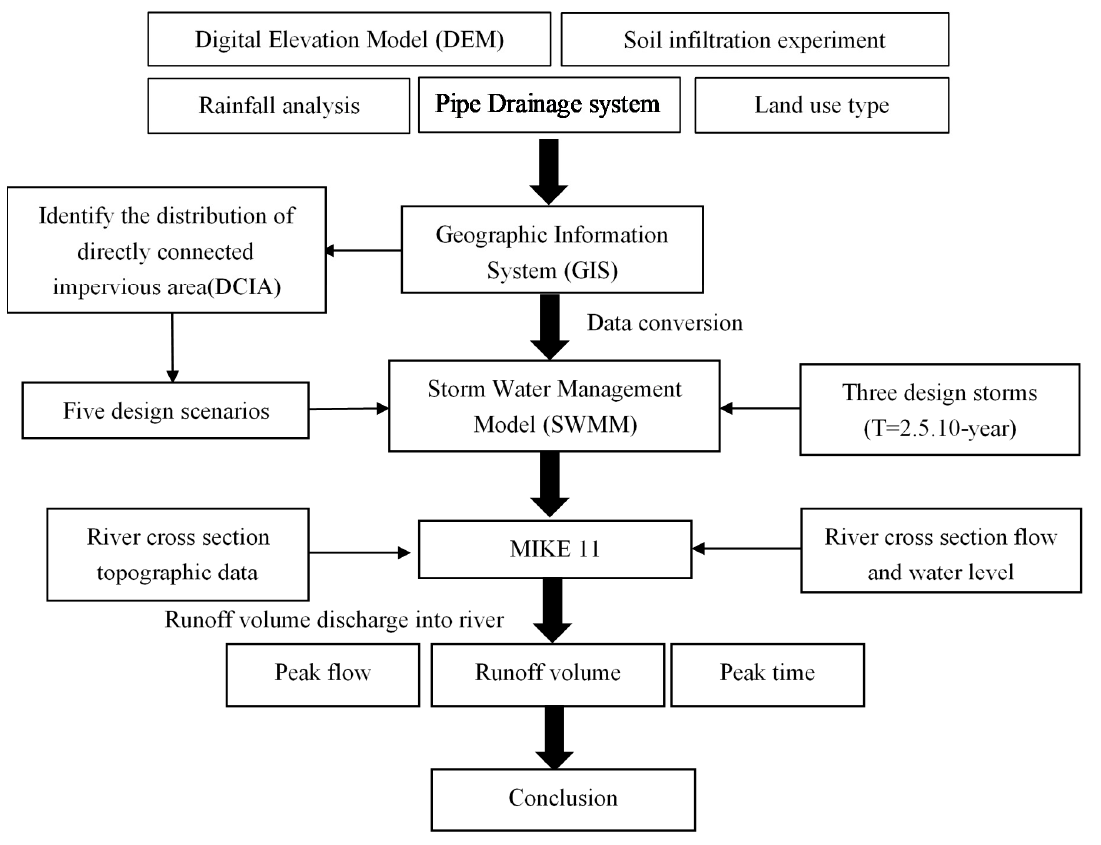
Figure 1. Description of the data requirements and processes.